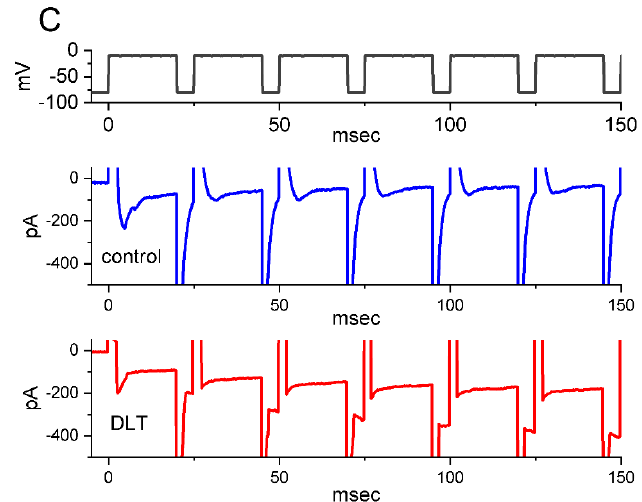
Figure 4. Effects of Tef ( A ) or DLT ( B , C ) on I Na evoked by a train of depolarizing pulses (i.e., pulse train [PT] stimulation) in GH 3 cells. The train given consists of 40–20 ms pulses (stepped to − 10 mV) separated 5 ms intervals at − 80 mV for a total duration of 1 sec. In ( A ) or ( B ), exemplar current traces acquired in the control period (i.e., neither Tef nor DLT was present, upper part, blue color) and during cell exposure to 10 μ M Tef (lower part, red color) or 10 μ M DLT (lower part, red color) are illustrated, respectively. The voltage-clamp protocol (black color) atop current traces in ( A – C ) is illustrated. The black dashed arrows in ( A ) or ( B ), respectively, indicate the direction of current changes (i.e., either decay or rise) over time in an exponential fashion, while the asterisk shows a large inward deflection following PT stimulation with cell exposure to 10 μ M Tef (upper) or 10 μ M DLT (lower). ( C ) Expanded records (i.e., potential or current traces) from the broken box in ( B ).